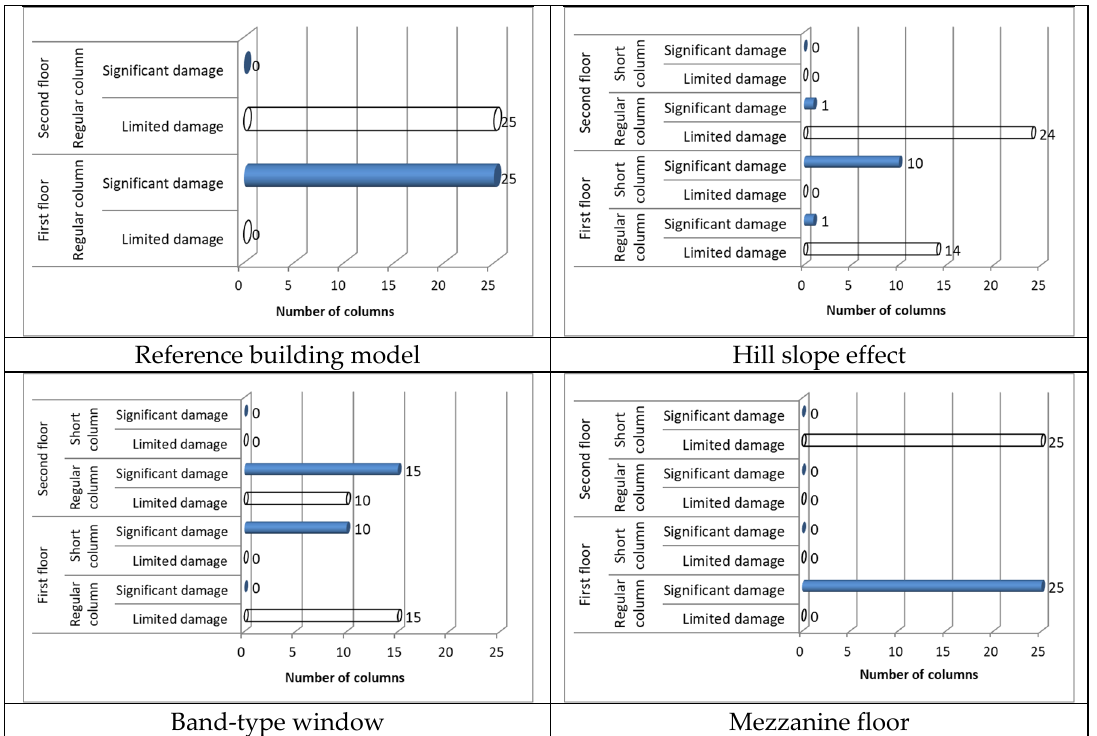
Figure 16. Column damage zones of the structural models.